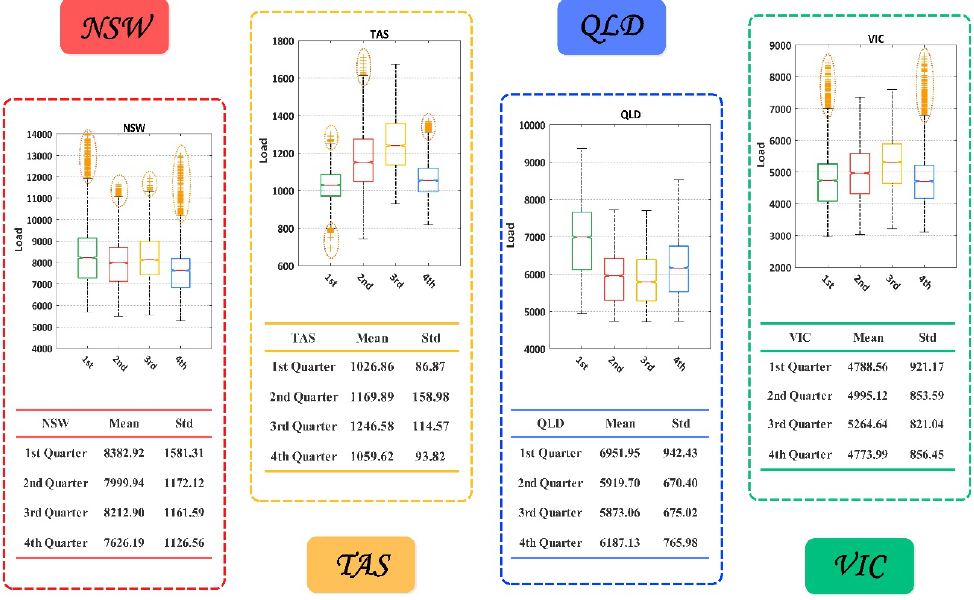
Figure 4. Boxplot of the entire set of data samples.